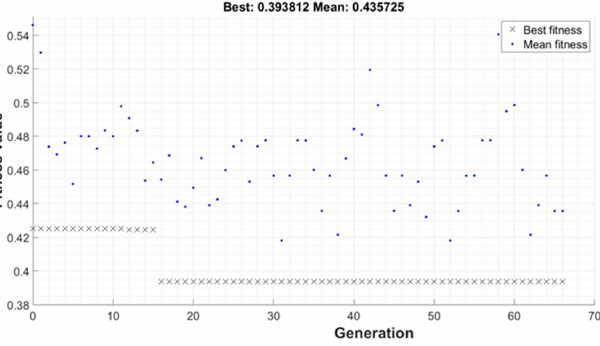
Figure 8. Optimization evolution of best and mean value for parameter 𝑑 The stresses field for the optimum case, where the blank distance, 𝑑 , and angle, α , were optimized, are presented in Figure 9, in the increment just before rupture.